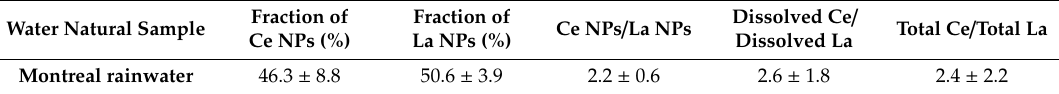
Table 4. Ratios of Ce to La determined in the Montreal rainwater, obtained using the SF-ICP-MS run in single particle mode with a dwell time of 50 µ s. Means and standard deviations were obtained from triplicate samples.